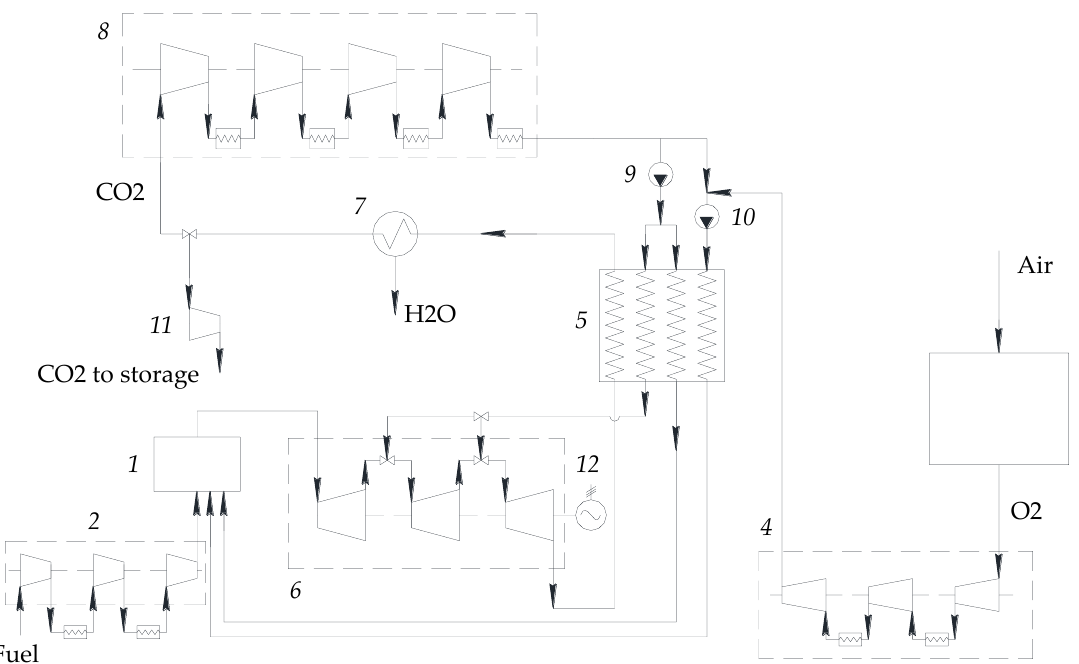
Figure 7. The Allam cycle that does not utilize the low-potential heat of the compressed air from the ASU in the regener- ator.